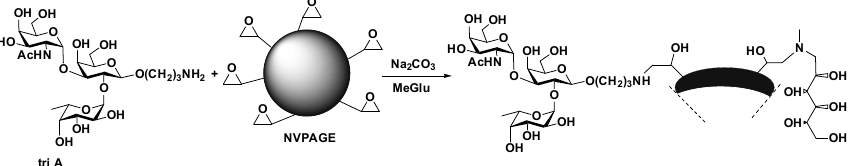
Figure 3. Numerical distribution (continuous) and intensity distribution (dotted line) of particle di- ameters in an aqueous solution of NVPAGE amphiphilic copolymer at a temperature of 298 K. Scheme 1. Conjugation of Trisaccharide A with the crown of NVPAGE